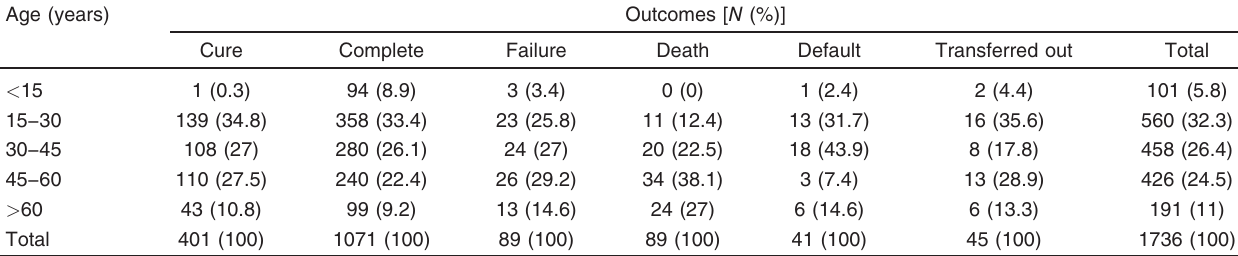
Table 9 Outcome of the study cases according to age group (2006 –